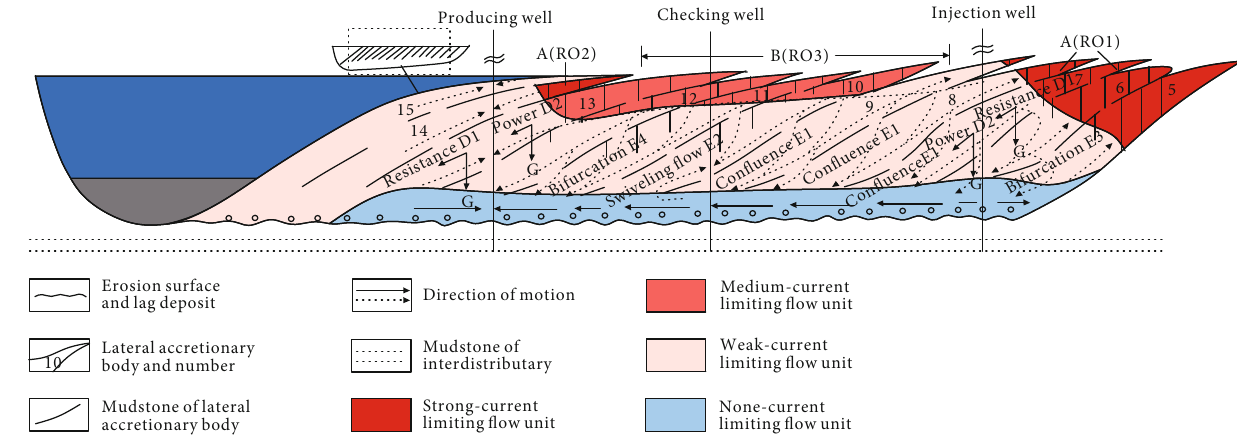
Figure 8: Flow units of the point-bar pattern in the development process. The injected water fl ows in the point bar to form three kinds of remaining oil and four types of fl ow units.